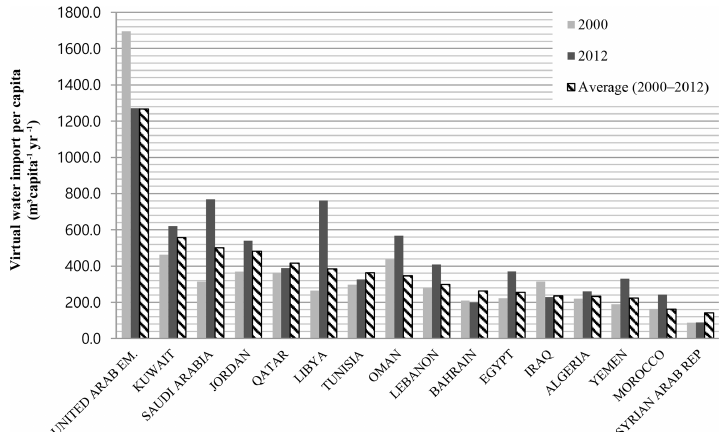
Figure 2. Virtual water imported per capita in the MENA region from 2000 to